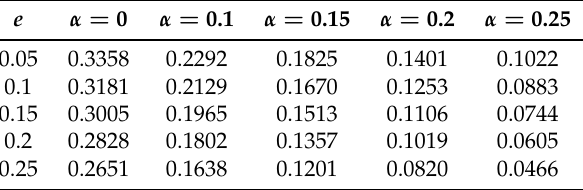
Table 5. Maximum allowable upper bounds b of Example 1.